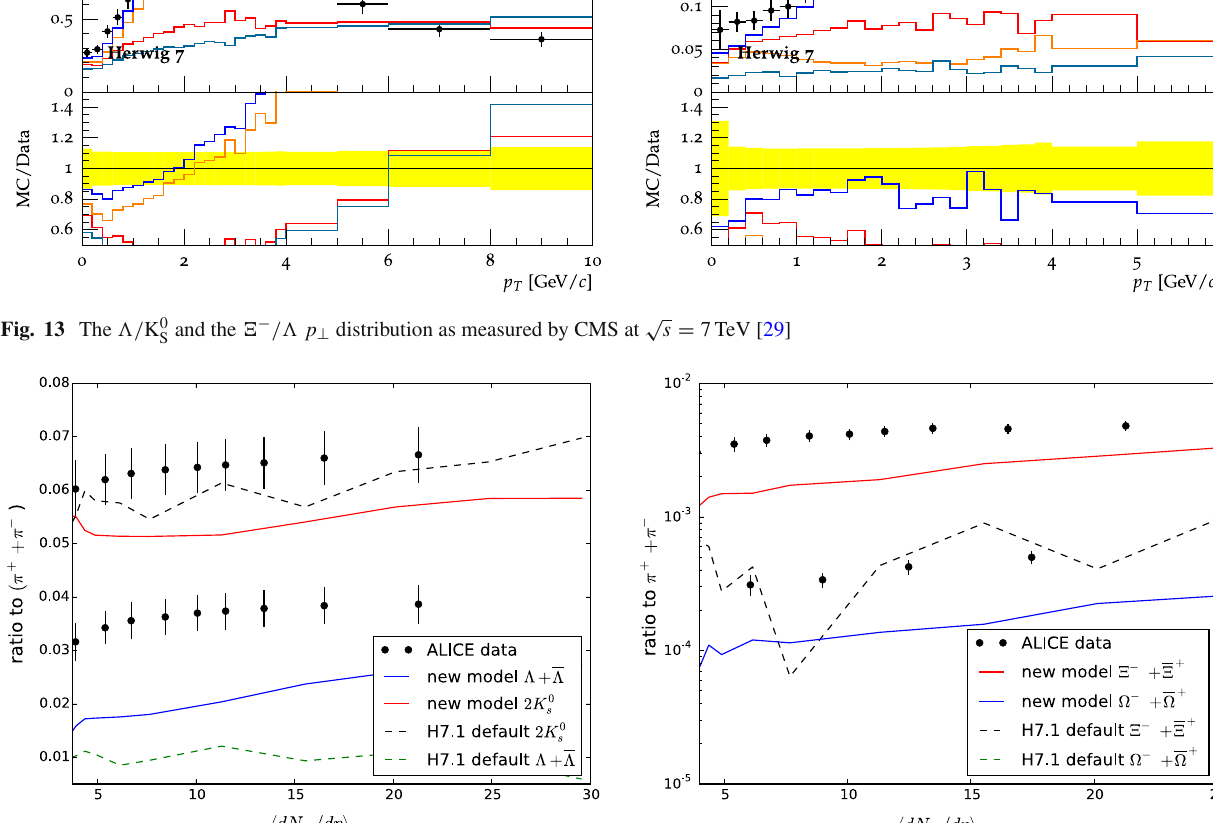
Fig. 14 Integrated (multi)-strange particle yield ratios to π + + π − as a function of (cid:10) d N ch / d η (cid:11) for | η | < 0 . 5. The values from the ALICE analysis [6] are compared to calculations from Herwig 7.1 with the old model and the new model for colour